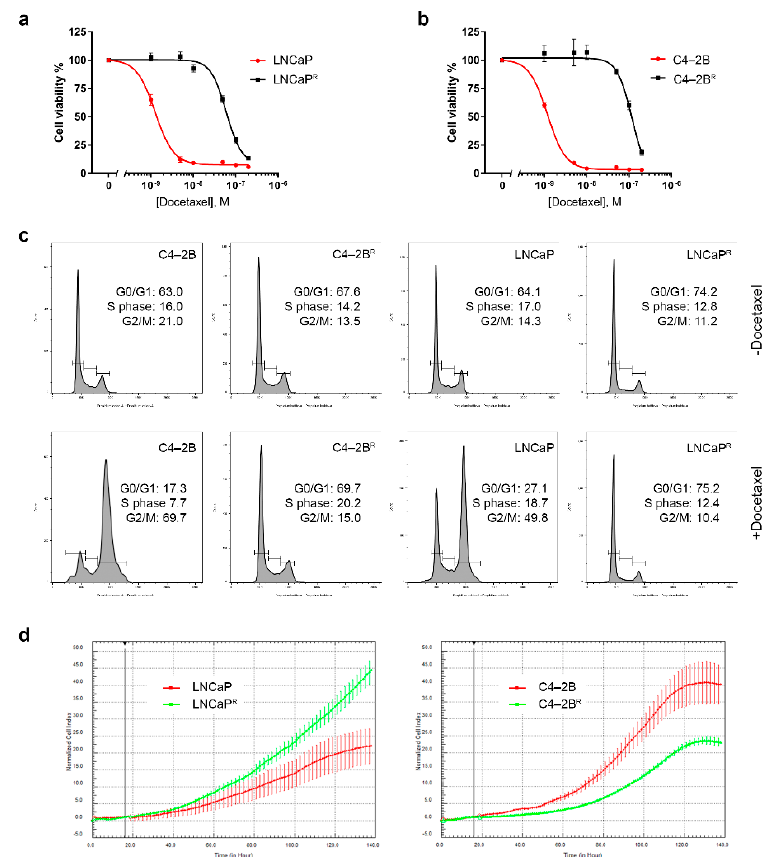
Figure 1. Docetaxel-resistant LNCaP R and C4-2B R cells. ( a ) and ( b ) Determination of IC 50 values of LNCaP R and C42B R cells, respectively. Cell viability was measured using a standard MTT assay, following exposure of cells to varying concentrations of docetaxel for 72 h. All plotted values are normalized to the untreated control. ( c ) Cell cycle profiles of LNCaP R and C4-2B R cells treated with docetaxel. After treatment with vehicle (DMSO) or 20 nM of docetaxel for 24 h, cells were harvested, fixed, and stained with PI before being analyzed by FACS. Data were analyzed using FlowJo software (BD Biosciences. ( d ) Real-time monitoring of cell growth rates with xCELLigence of LNCaP/LNCaP R and C4-2B/C4-2B R